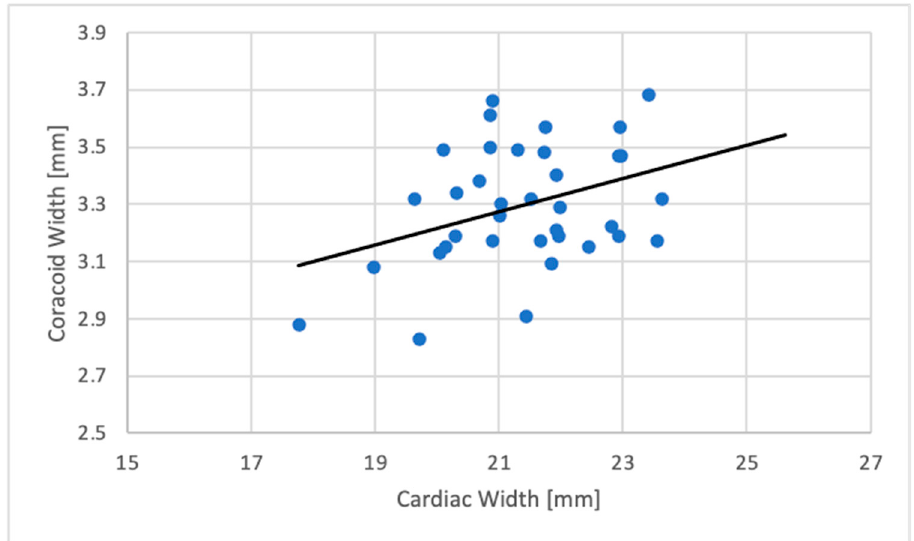
Figure 4. Scatterplot showing the relation between the cardiac silhouette width (mm) and the cora- coid width (mm) in the VD radiographic projection ( N = 36).